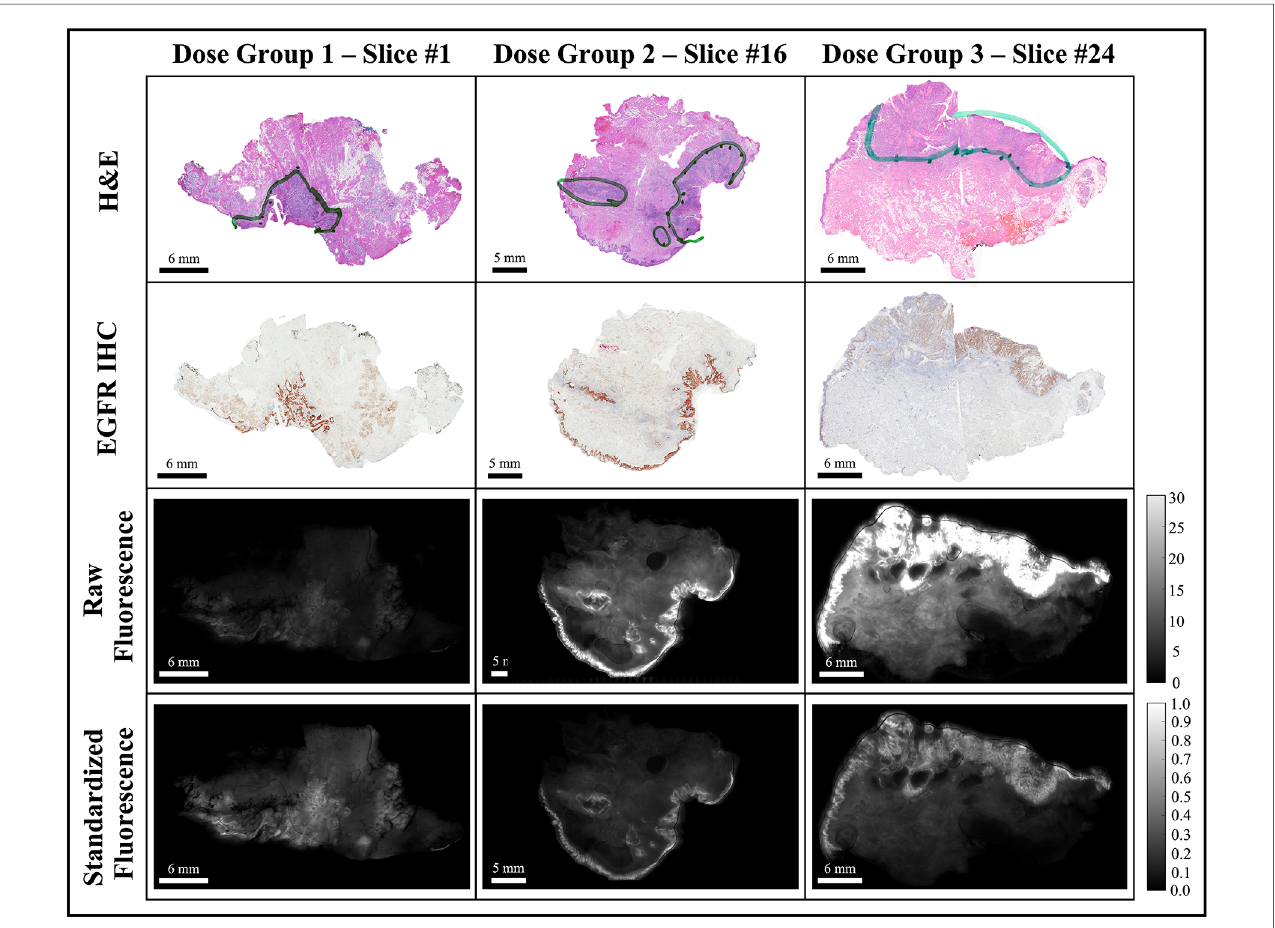
FIGURE 3 Representative bread-loaf slices from the three dose groups (30, 90, and 171 nanomoles). Green contours in the H&E images indicate ground truth tumor regions delineated by an expert pathologist (L.J.T.). The bottom two rows show comparisons of fl uorescence images before (raw fl uorescence) and after image pre-processing (standardized fl